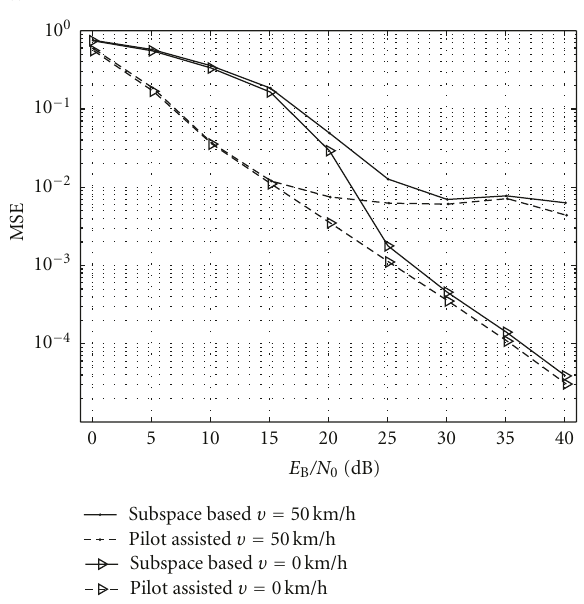
Figure 8: MSE as a function of E B /N 0 with the velocity v as parameter for the WINNER SCM urban macrocell channel and assuming that Q = 8, K = 30, and U =